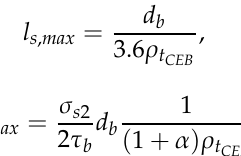
Figure 3. The e ff ective area Figure 3. The effective area [55].